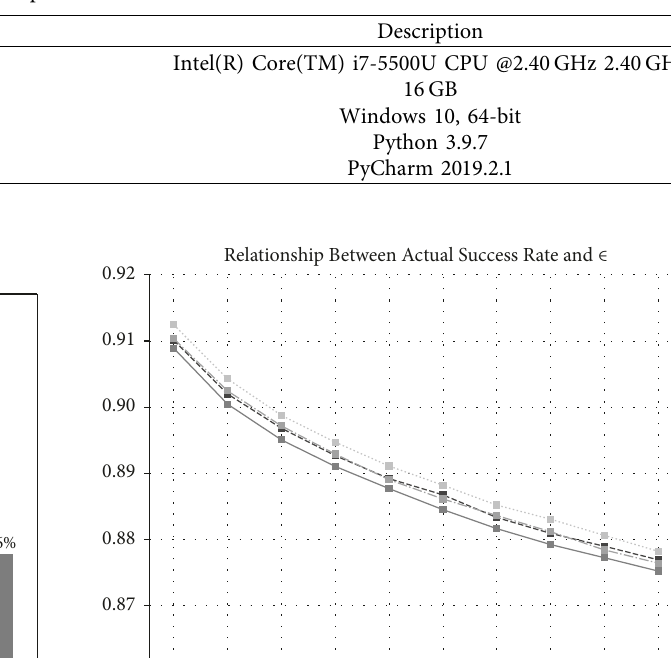
Table 5: The experimental environment.